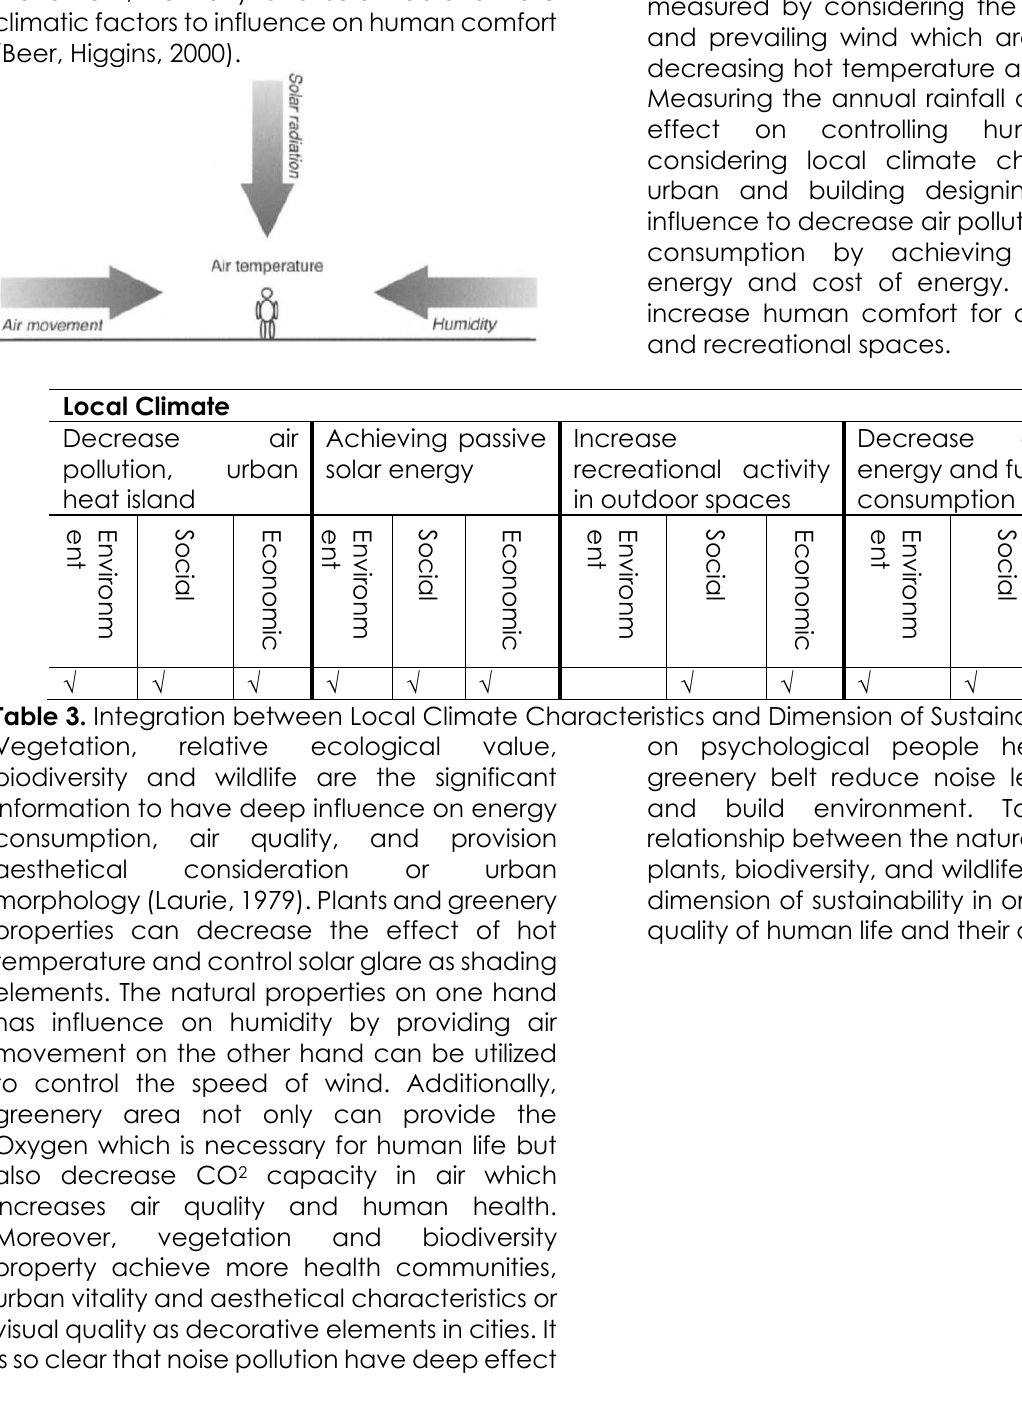
Suitable space or building orientation, receiving natural lighting, appropriate shading